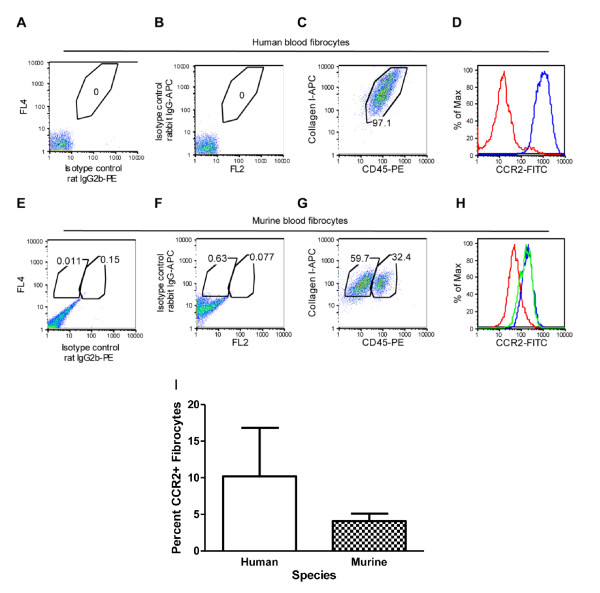
Positive chemokine (C-C motif) receptor 2 (CCR2) expression in human and murine blood fibrocytes by flow cytometry. Representative flow cytometric analysis of fibrocytes stained after primary passage with collagen I, CD45 and CCR2 or isotype controls. (C) Collagen I and CD45 staining of human fibrocytes with gate parameters calculated based in isotype controls (A and B). (D) Representative histogram of CCR2 expression (blue) in human fibrocyte population compared to IgY isotype control (red). (G) Collagen I and CD45 staining of murine fibrocytes with gate parameters calculated based in isotype controls (E and F). (H) Representative histogram of CCR2 expression (blue) and collagen I (green) compared to relevant isotype control (red). (I) Quantitative analysis of percentage of CCR2+ cells in fibrocyte population. Data are expressed as the mean ± SEM of n = 4 human donors and n = 30 mice.